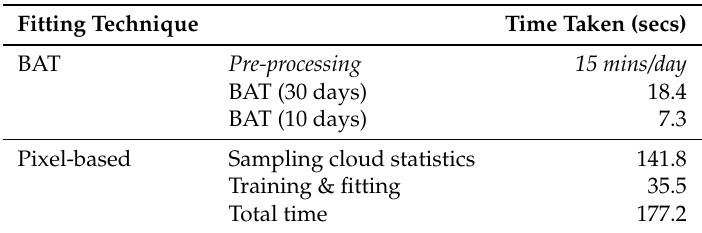
Table 3. Comparison of time taken to provide a temperature fitting using the pixel-based training technique and the BAT fitting